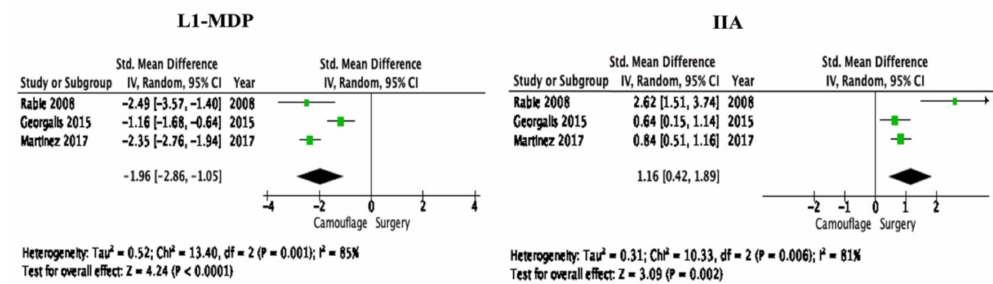
Figure 4. Forest plot of dental